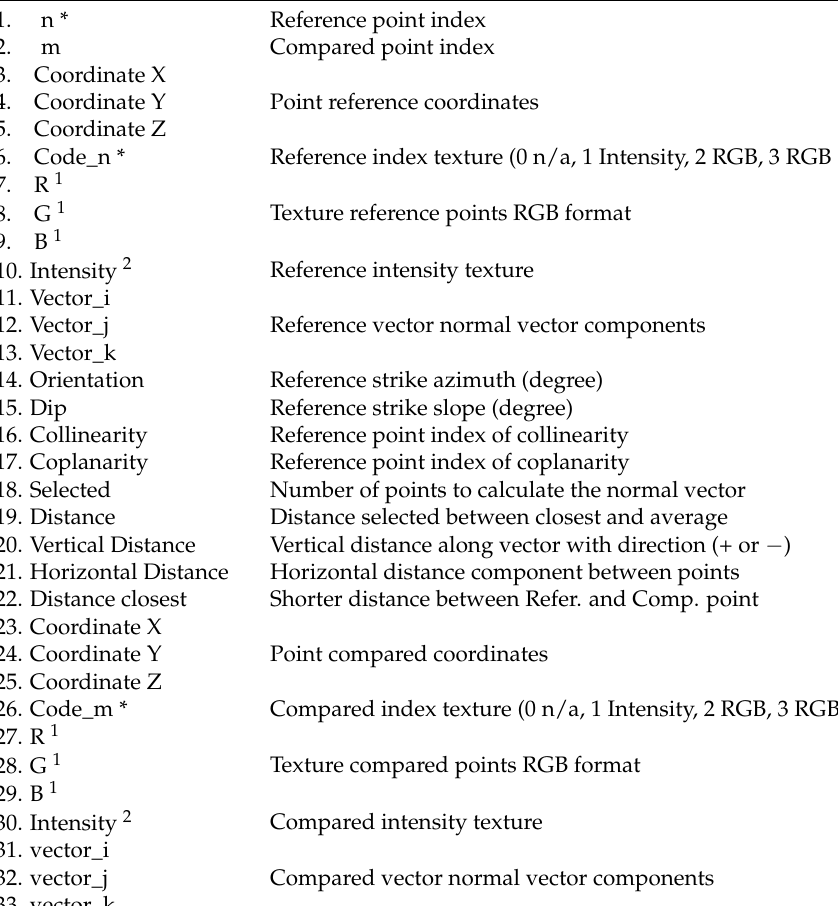
Table A2. Features associated with the point cloud after calculating differences. * No computed as features. 1 Only computer with RGB format is used. 2 Only computed with Intensity format is